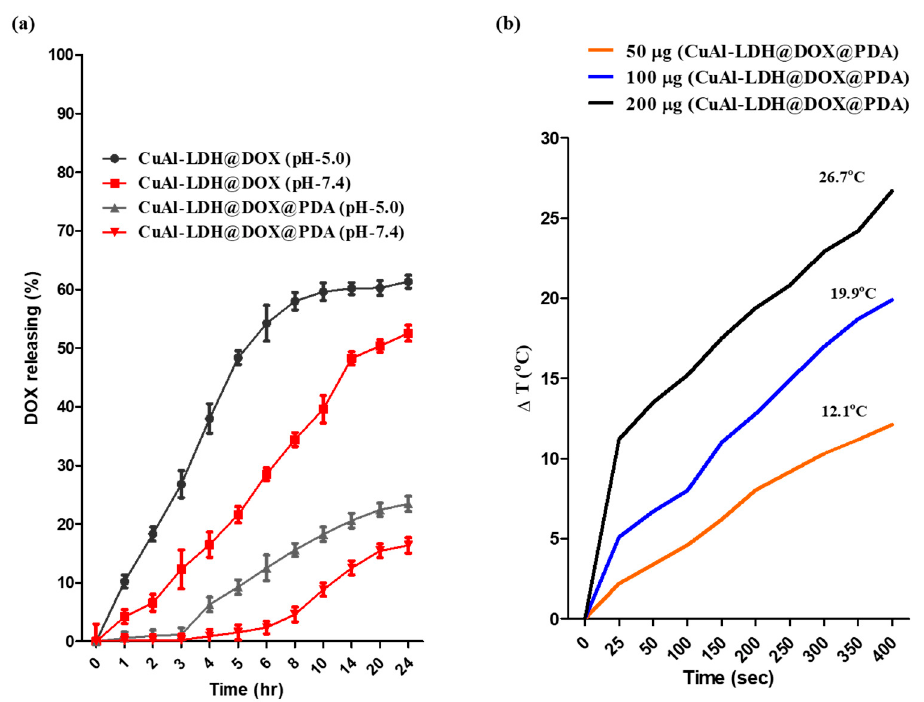
Figure 3. ( a ) DOX releasing from CuAl-LDH@DOX and CuAl-LDH@DOX@PDA over time at various PBS solutions of pH 5.0 and 7.4 (at 37 °C). ( b ) Temperature increasing profiles of CuAl-LDH@DOX@PDA under 808 nm laser irradiation over time (50, 100, and 200 µg/mL).